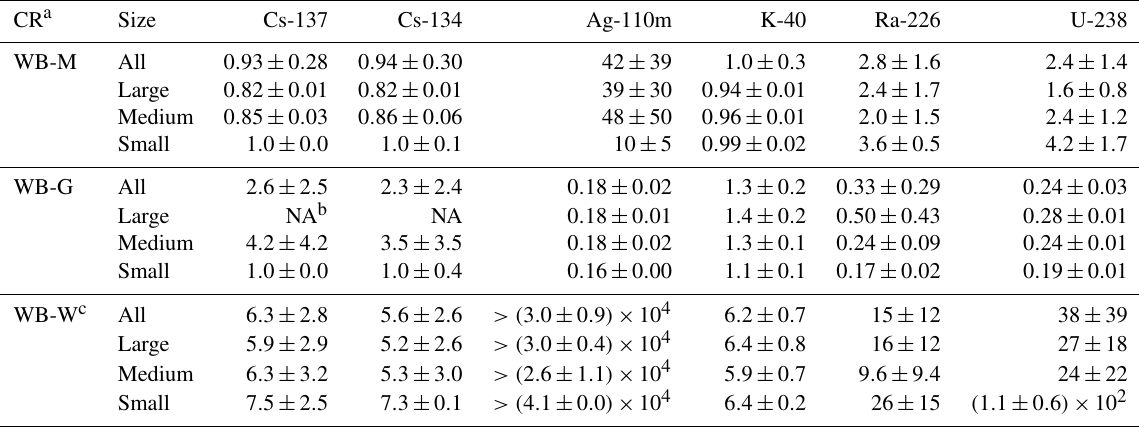
Table 2. Concentration ratios for radionuclides in 2011 following the accident (see text). CR a Size Cs-137 Cs-134 Ag-110m WB-M All 0 . 93 ± 0 . 28